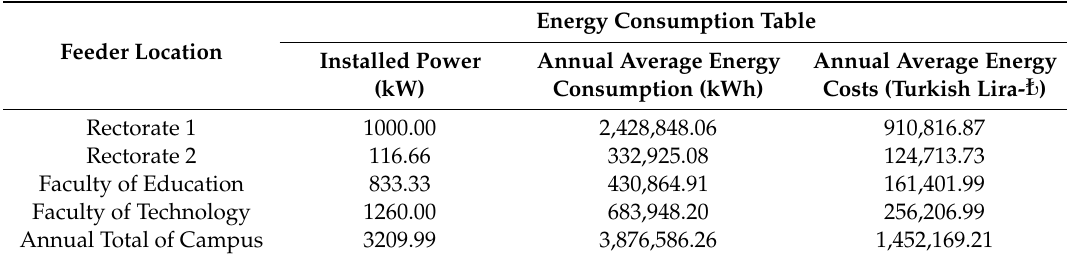
Table 4. Electrical Energy Features in the Campus (2017).